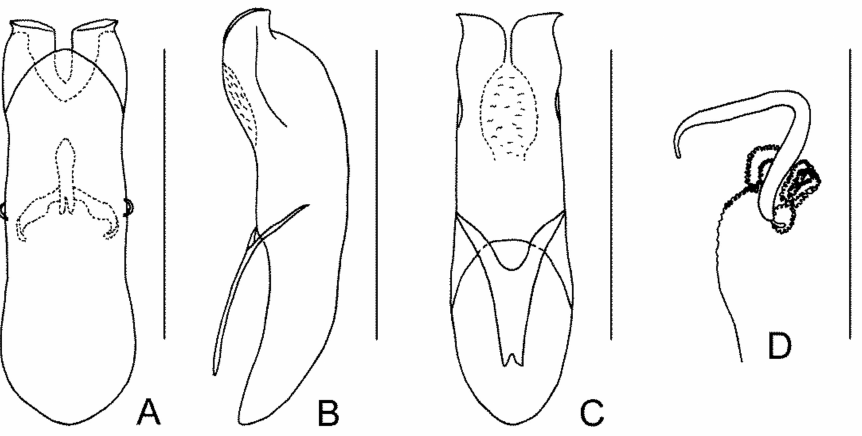
Figure 19. Cryptocephalus ( Burlinius ) fulvus (Goeze, 1777): ( A ) habitus; ( B ) lateral view of habi- tus; ( C ) spermatheca; ( D ) lateral view of aedeagus; ( E ) dorsal view of aedeagus; ( F ) ventral view of aedeagus. (Scale bars: ( A , B ) = 0.5 mm, ( C – F ) = 0.2 mm) (( A , B , D – F ): male; ( C ): female; both from Hebei).